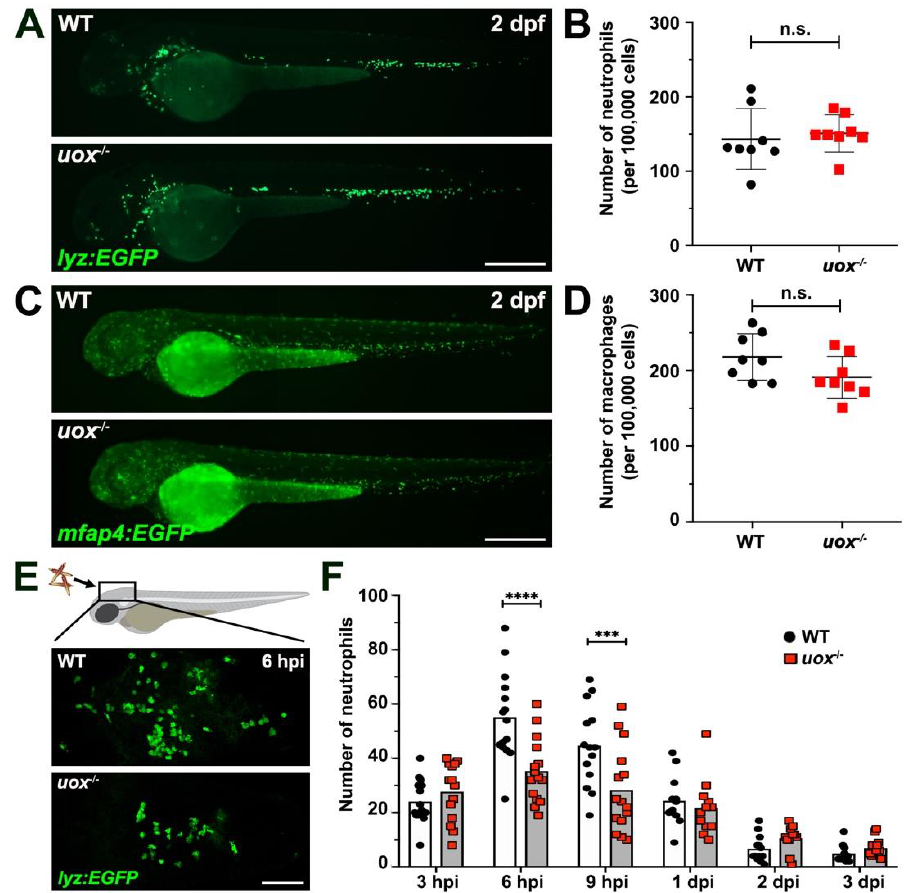
Figure 5. Uricase-deficient larvae demonstrate unaltered myelopoiesis and dampened neutrophil recruitment towards MSU crystal challenge. ( A ) Live imaging of neutrophils within 2 day post fertilization (dpf) WT and uox − / − Tg(lyz:EGFP) larvae. ( B ) Flow cytometry quantification of neutrophils within 2 dpf WT and uox − / − Tg(lyz:EGFP) larvae ( n = 8 groups per genotype, 20 larvae per group). ( C ) Live imaging of macrophages within 2 dpf WT and uox − / − Tg(mfap4:EGFP) larvae. ( D ) Flow cytometry quantification of macrophages within 2 dpf WT and uox − / − Tg(mfap4:EGFP) larvae ( n = 8 groups per genotype, 20 larvae per group). Statistical significance in ( B , D ) determined using unpaired two-tailed Student’s t tests. ( E ) Immunofluorescent detection of neutrophils within the hindbrain ventricle of WT and uox − / − Tg(lyz:EGFP) larvae, at 6 h post MSU crystal injection (hpi). ( F ) Quantification of neutrophil recruitment, as detected in ( E ), within WT (white bars) and uox − / − (grey bars) Tg(lyz:EGFP) larvae at 3, 6 and 9 hpi and 1, 2 and 3 days post MSU crystal injection (dpi), n = 12–15 larvae per treatment. Statistical significance determined using multiple unpaired Student’s t-tests with Holm–Sidak correction. Error bars in ( B , D , F ) represent means ± SDs. Abbreviations: n.s. not significant, *** p < 0.001 and **** p < 0.0001. Scale bars: 200 µ m in ( A , C , E